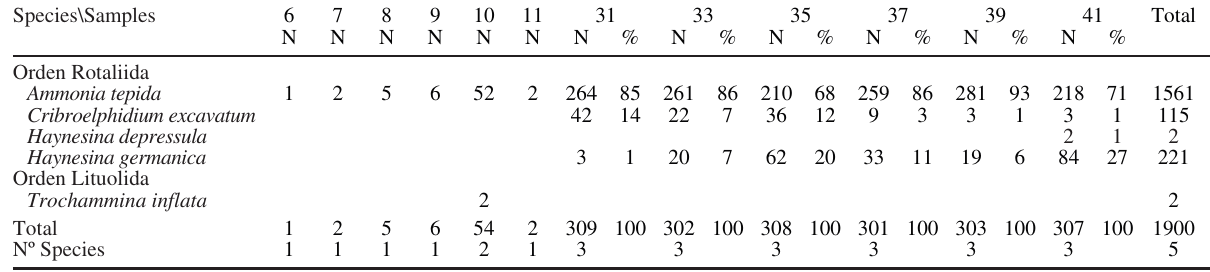
Table 3. – Number of individuals and species of benthic foraminifera in core S-4 (N, number of individuals). Species\Samples